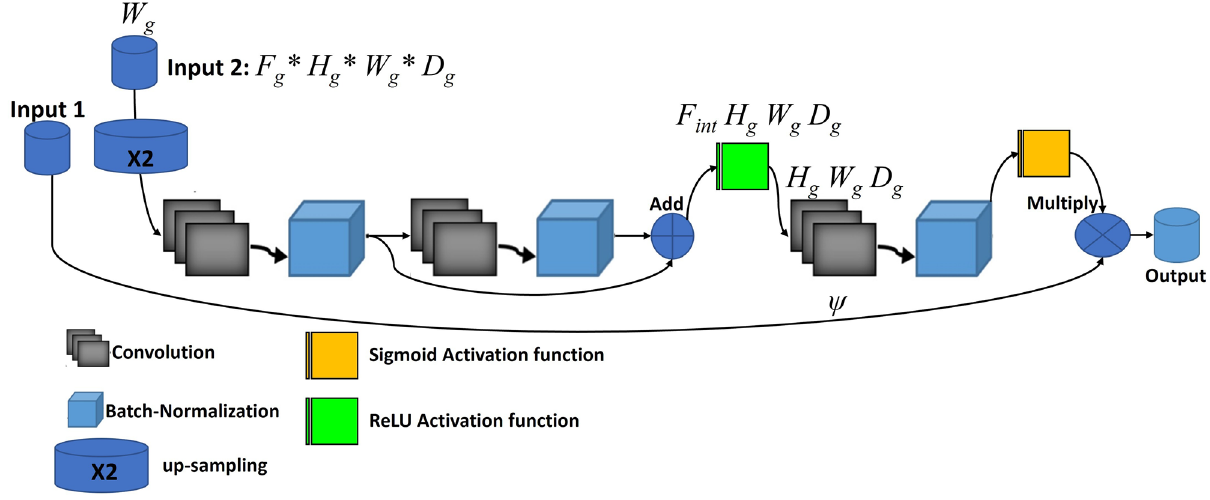
Figure 3. Overview of the proposed attention gate